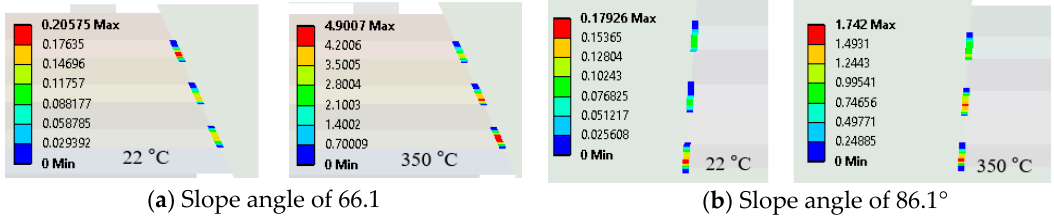
Figure 17. Contact stress distribution at graphite of the 7-layer model with graphite thickness of 0.8 mm. Table 7. Comparison of peak contact stress at the new seal with those at the 1-layer, 3-layer, and 5- layer models (350 °C).